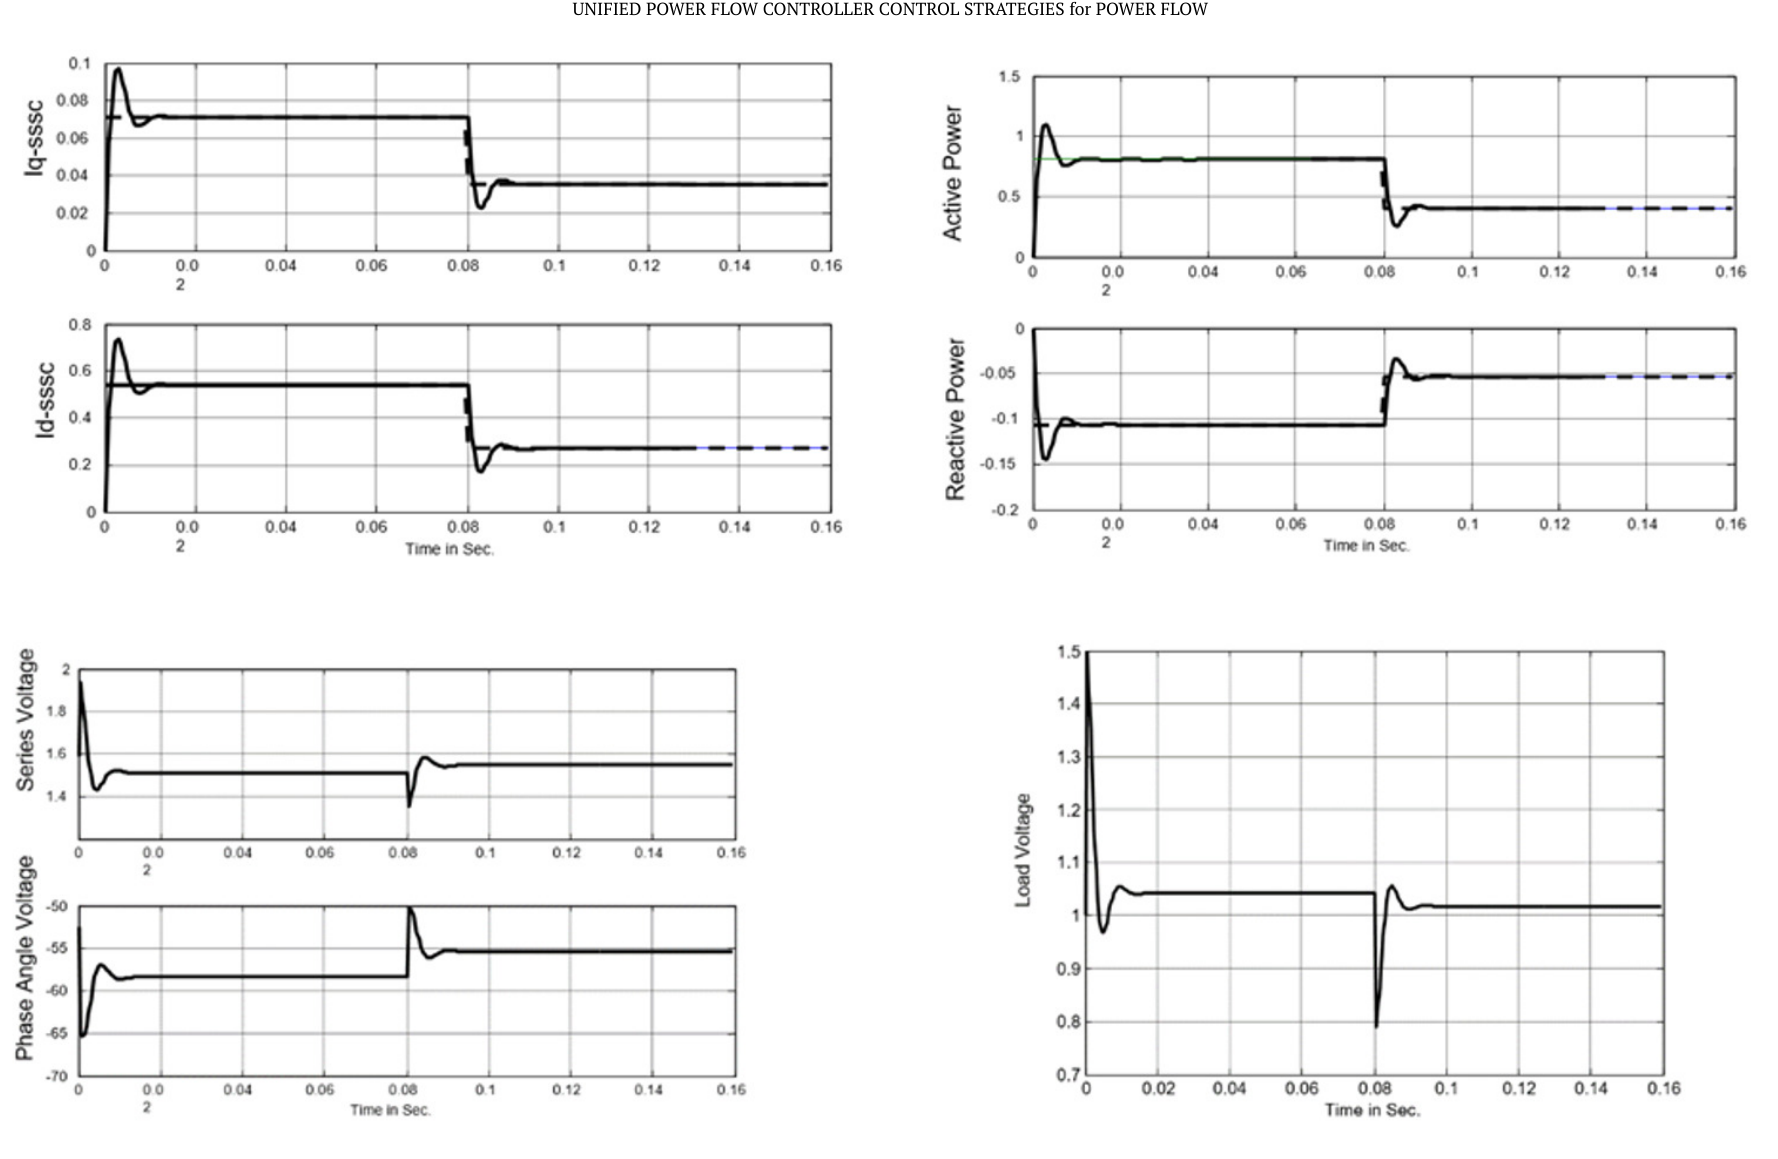
Figure 13. The transient performance of the SSSC in case of Active and Reactive Power Variations with